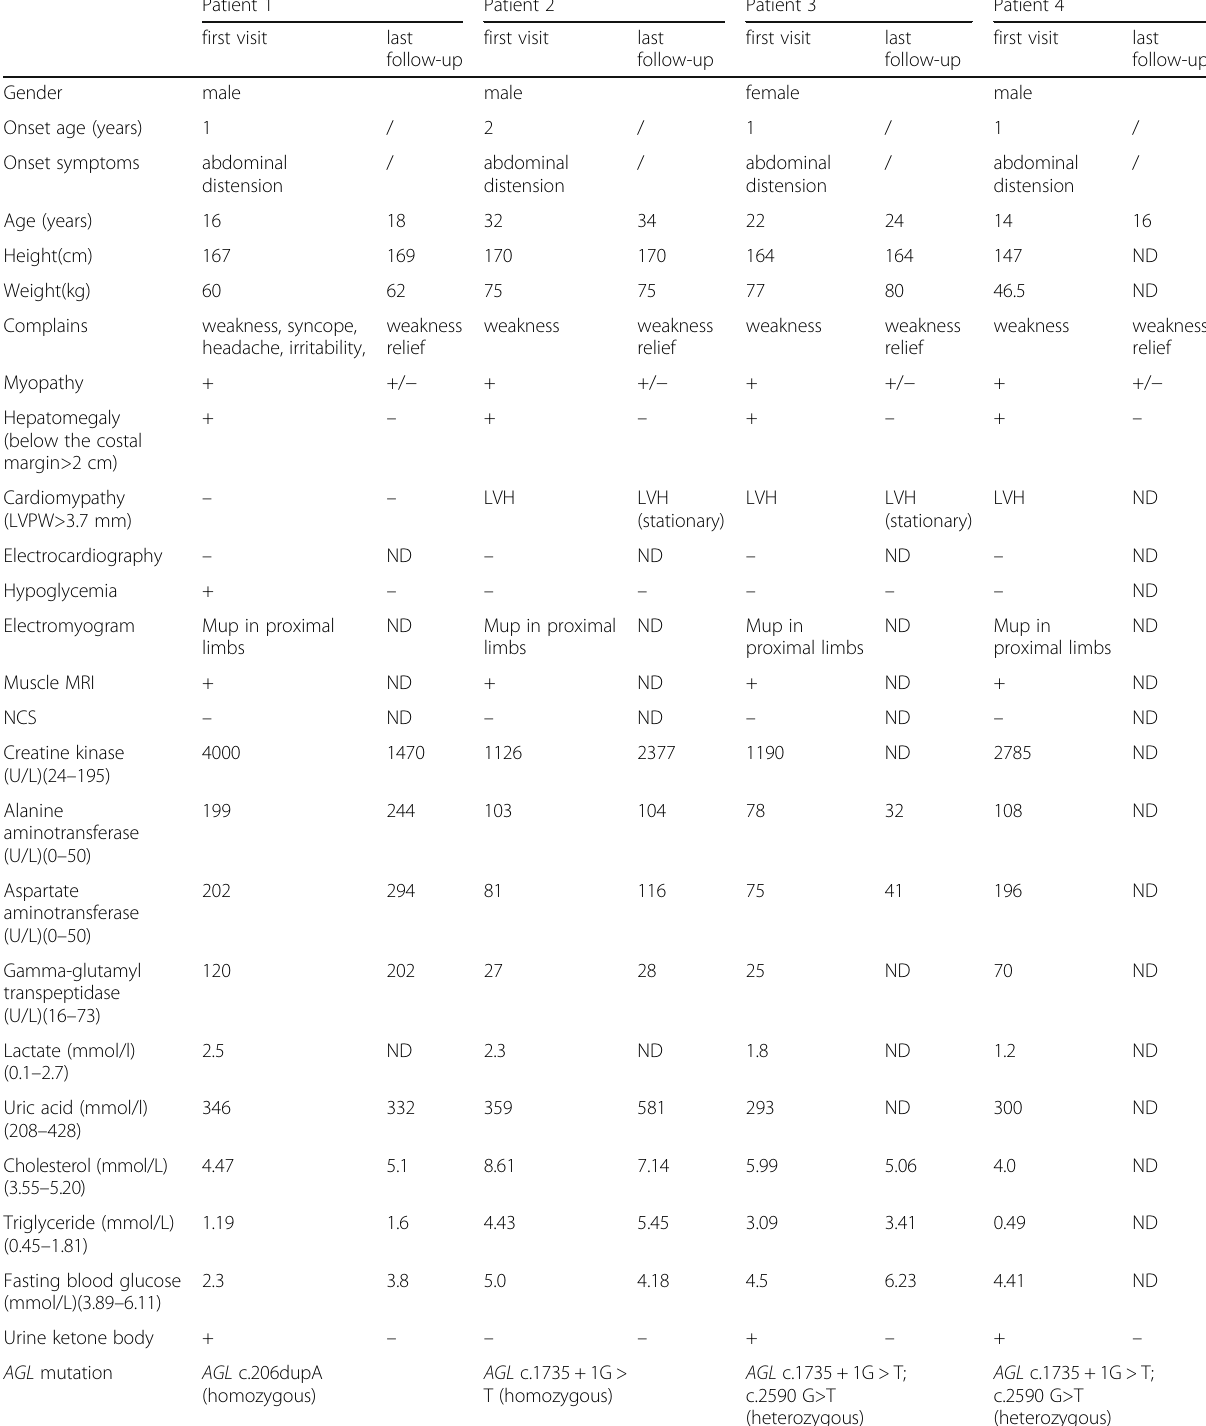
Table 1 Clinical features and gene mutation of GSD IIIa